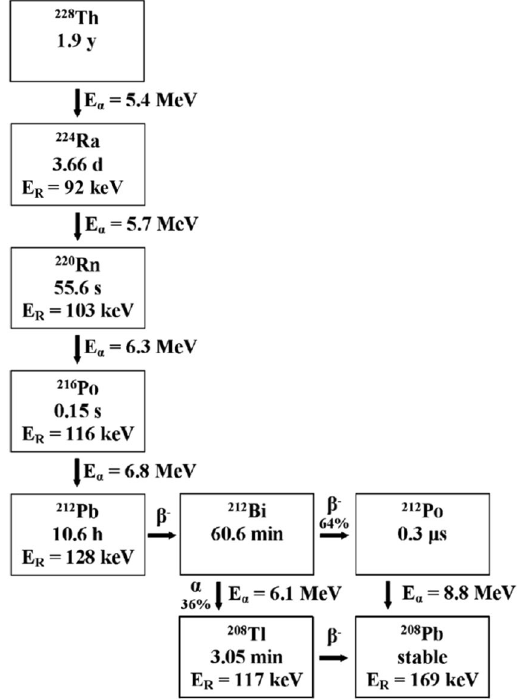
Figure 1. The nuclear decay chain of 228 Th. Decay mode, daughter nuclei and recoil energy (E R ), α -emission energy (E α ) and the half-life are specified 45